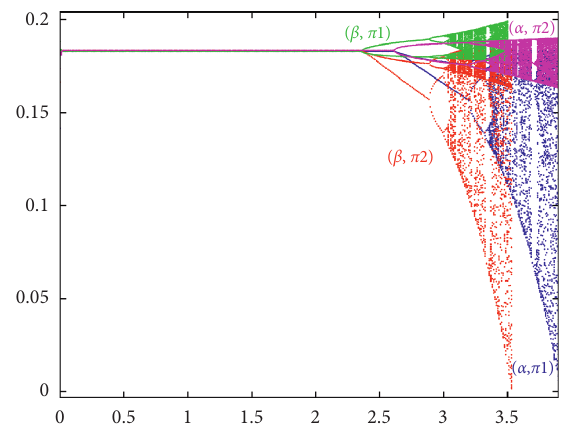
Figure 13: The bifurcation diagram of the profit under collective bargaining.